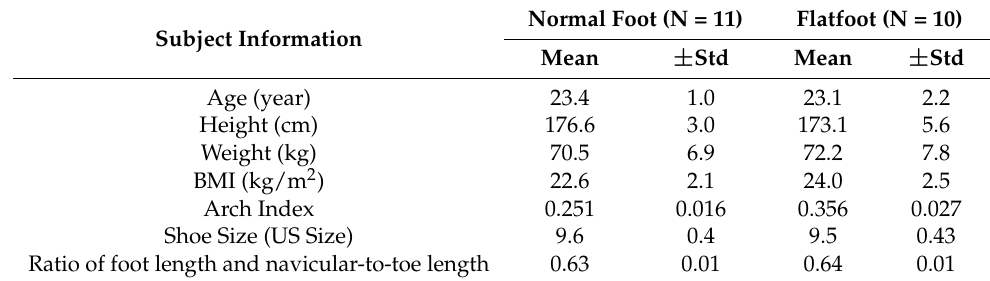
Table 1. Subject characteristics of 21 young subjects who participated in this